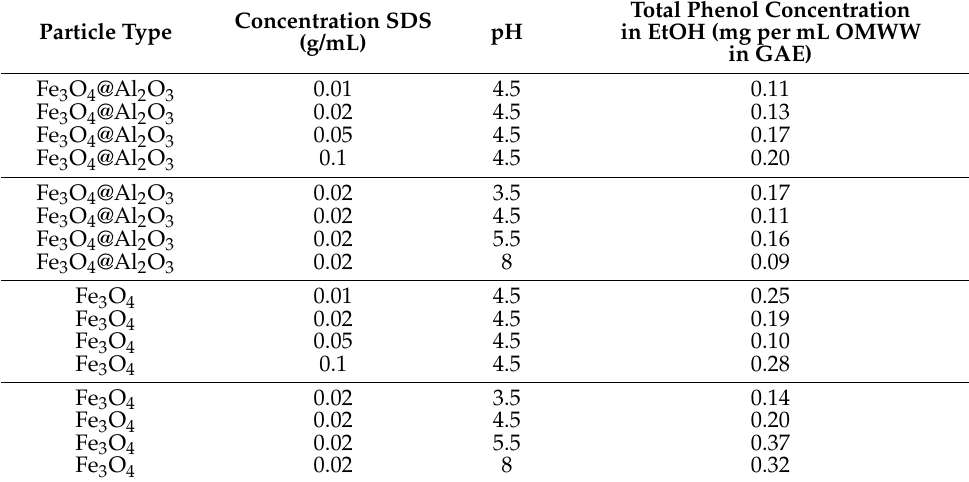
Table 5. Treatment of OMWW with Fe 3 O 4 @SDS or Fe 3 O 4 @Al 2 O 3 @SDS with different synthesis parame- ters (pH, SDS concentration). The concentration of the desorbed total phenol content was measured using the Folin–Ciocalteu method. The standard deviation of the results is 0.02 mg per mL